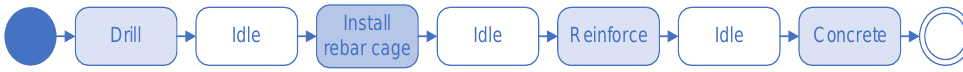
Figure 10. DES model (circles: Source/Sink; white: LoD1; light blue: LoD2; and blue: LoD3).